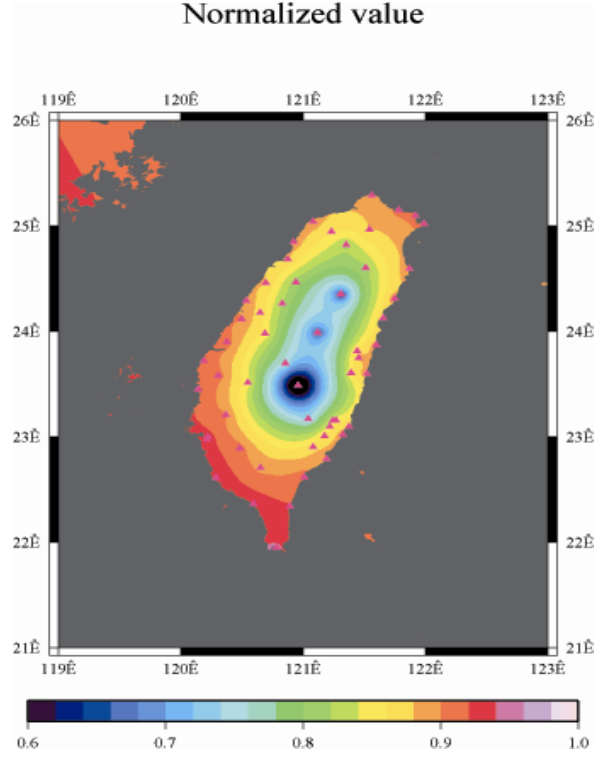
Figure 19. Normalized ZTD values around the island during plum rains (June 2nd, 2008, 5:00